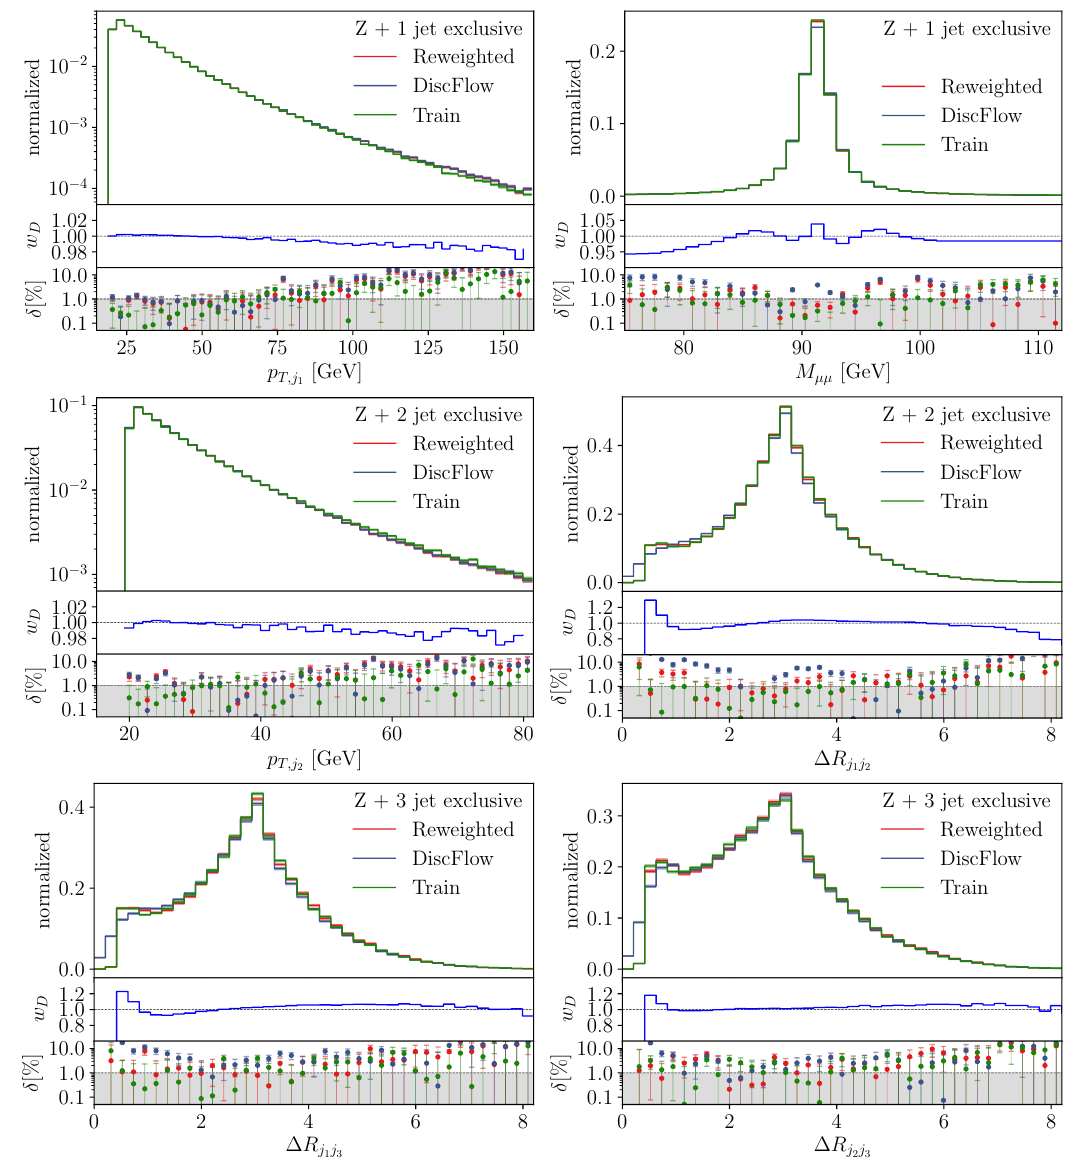
Figure 8: Discriminator-reweighted DiscFlow distributions for Z + 1 jet (upper), Z + 2 jets (middle), and Z + 3 jets (lower) from a combined Z + jets generation. The bottom panels show the average correction factor obtained from the discrimina- tor output. The DiscFlow results for joint generator–discriminator training without reweighting are the same as in Fig.